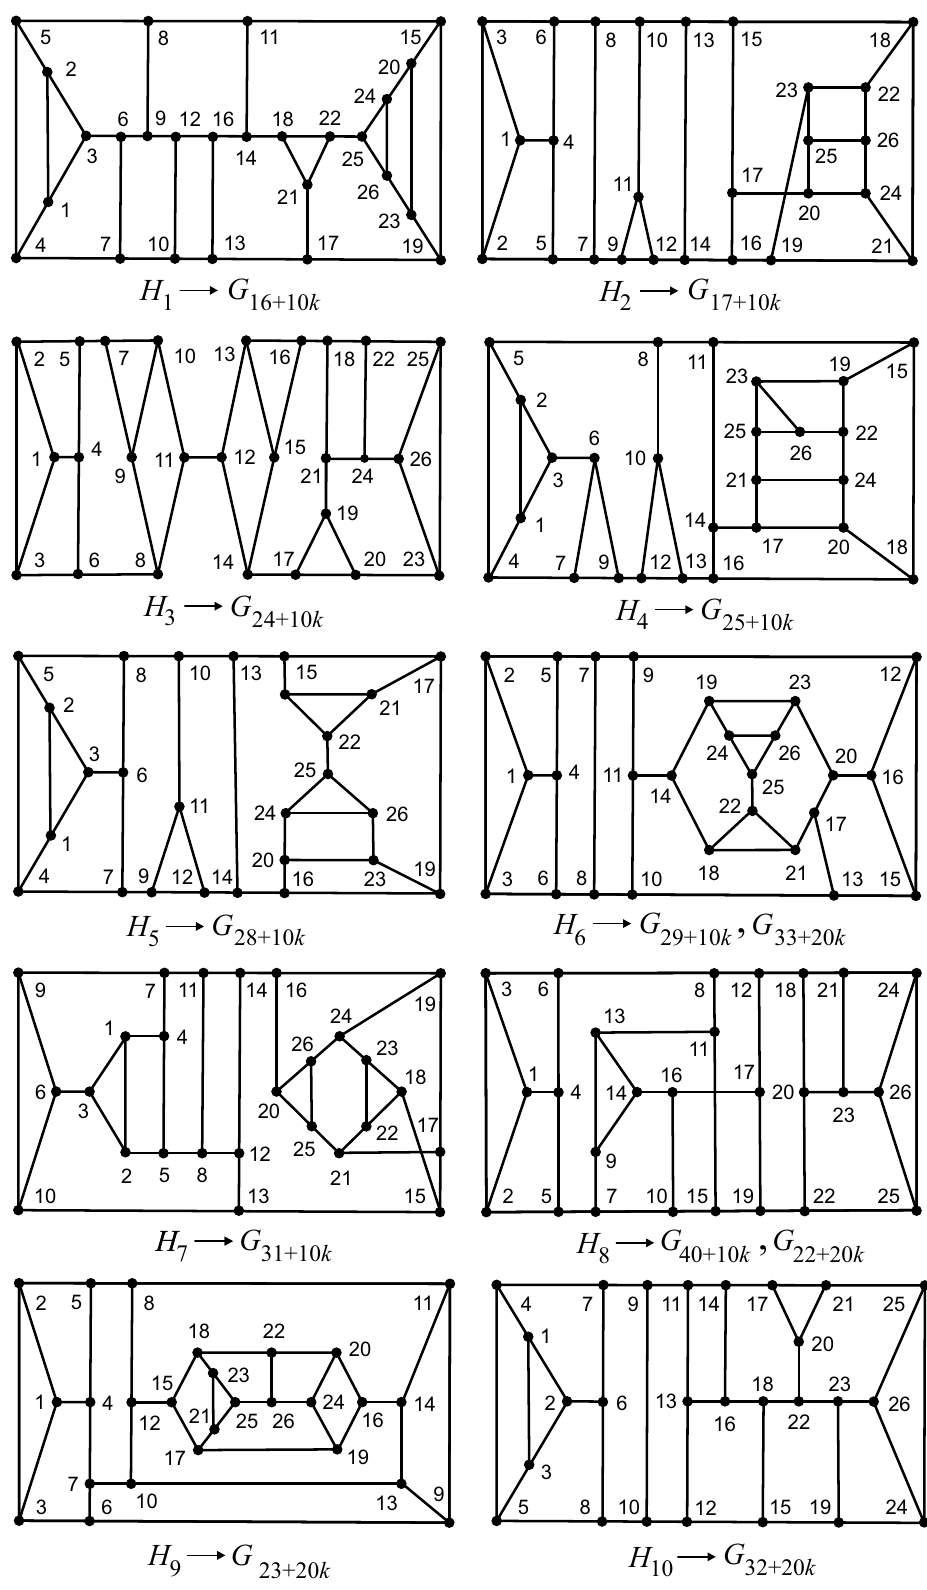
Figure 3. Transmission irregular cubic graphs of order